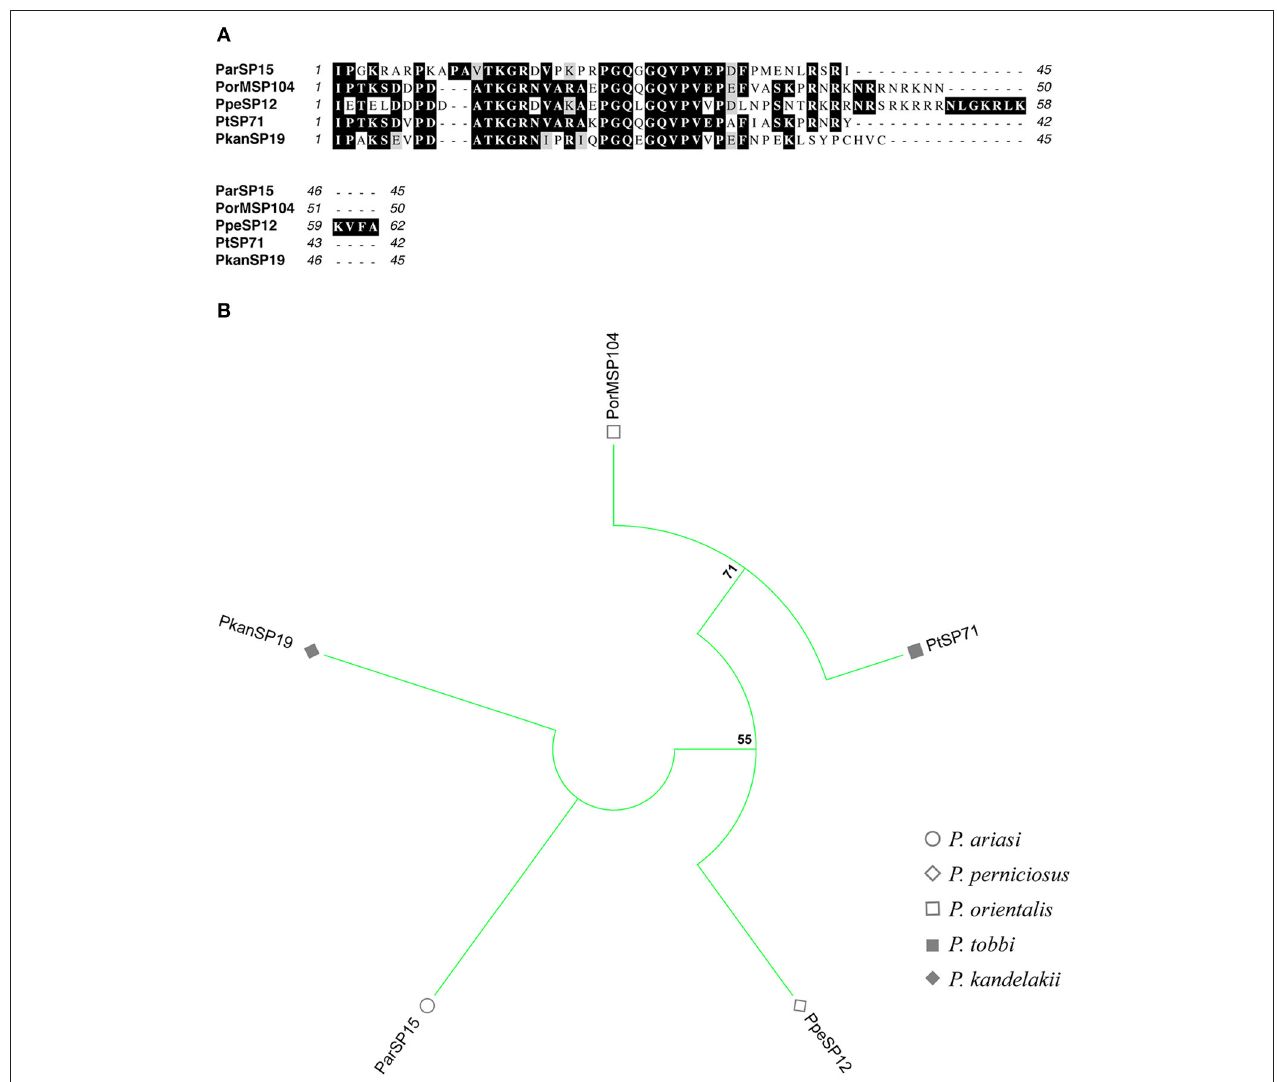
FIGURE 7 | Multiple sequence alignment and molecular phylogenetic analysis of the sand fly ParSP15 salivary protein family. (A) Multiple sequence alignment of ParSP15 proteins . ParSP15 ( P. ariasi ), PorMSP104 ( P. orientalis ), PpeSP12 ( P. perniciosus ), PtSP71 ( P. tobbi ), and PkanSP19 ( P. kandelakii ). Black background shading represents identical amino acids. Gray background shading represents similar amino acids. (B) The evolutionary history of ParSP15 salivary protein family was inferred by using the Maximum Likelihood method based on the JTT matrix-based model (Jones et al., 1992). Sand fly species are indicated by the different symbols in the legend on the